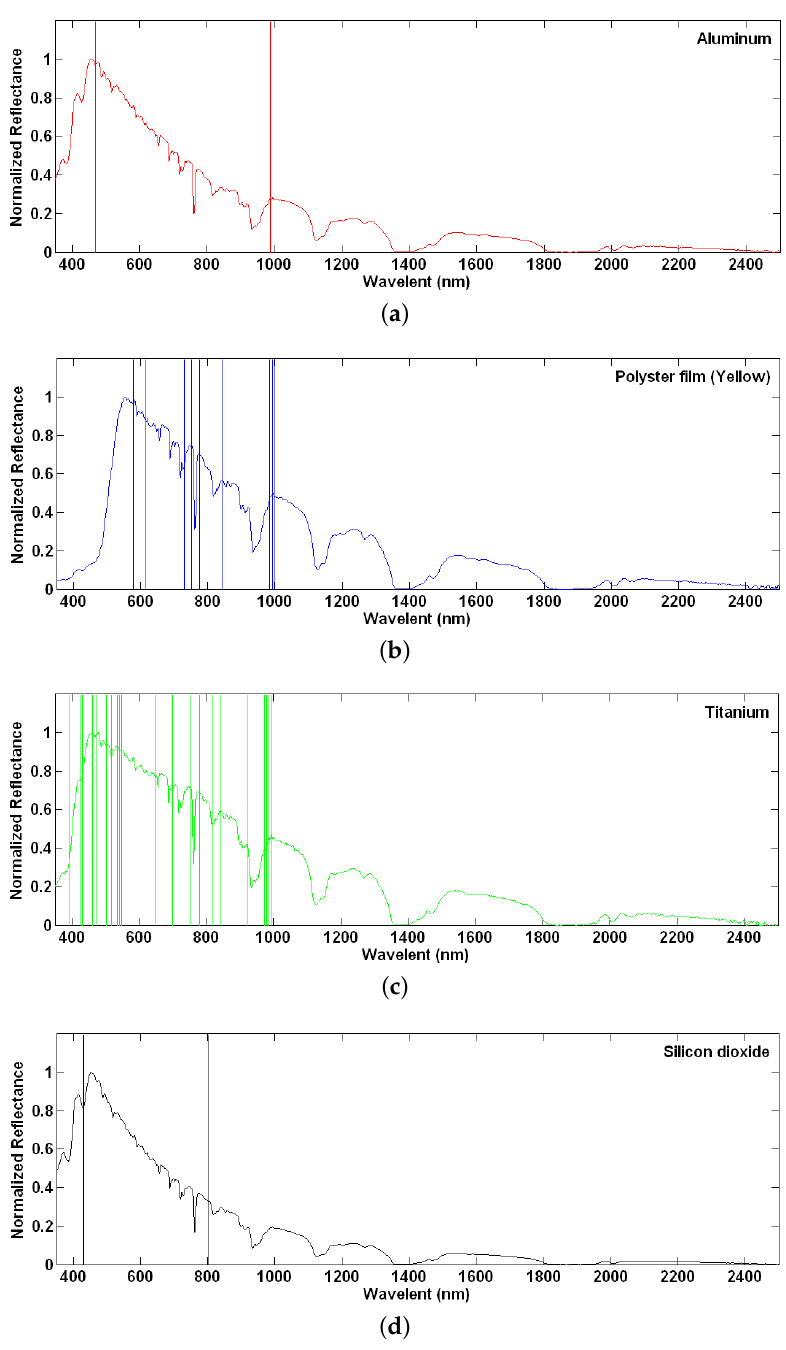
Figure 4. Spectral curves of four types of materials and their unique absorption features (labeled by vertical lines). ( a ) aluminum; ( b ) polyester film (yellow); ( c ) titanium; ( d ) silicon